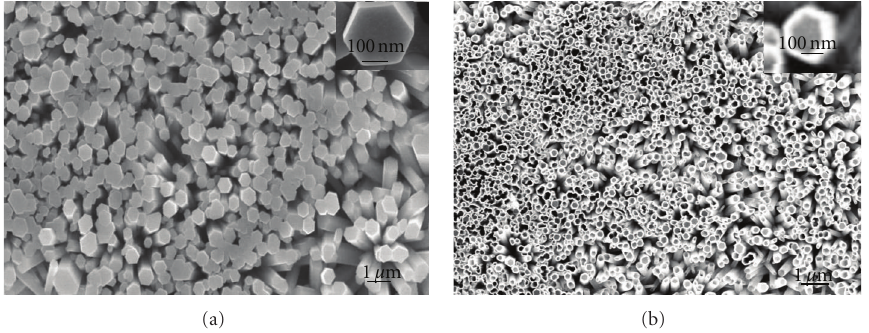
Figure 1: (a) Typical SEM image of the ZnO NRs arrays grown on paper substrate. Inset shows high-magnification image of a single ZnO NR. (b) SEM image of the ZnO NTs grown on paper substrate. Inset shows high-magnification image of a single ZnO